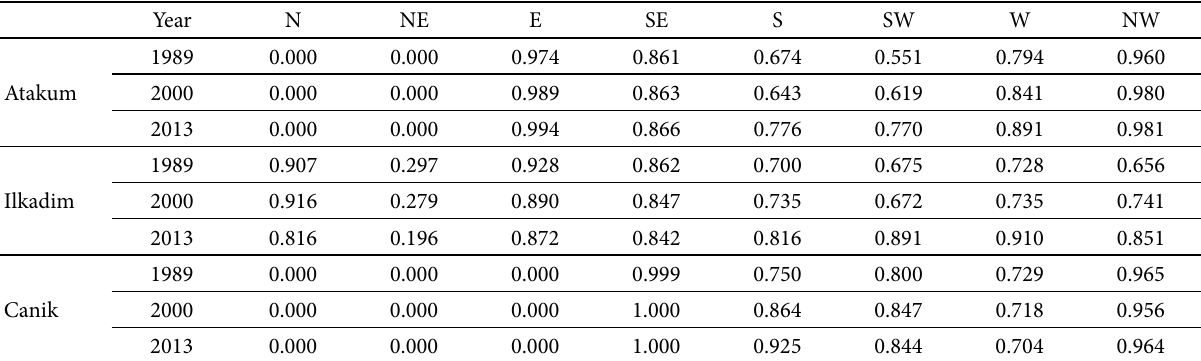
Table 3. Shannon’s entropy in 1989, 2000, and 2013 for all